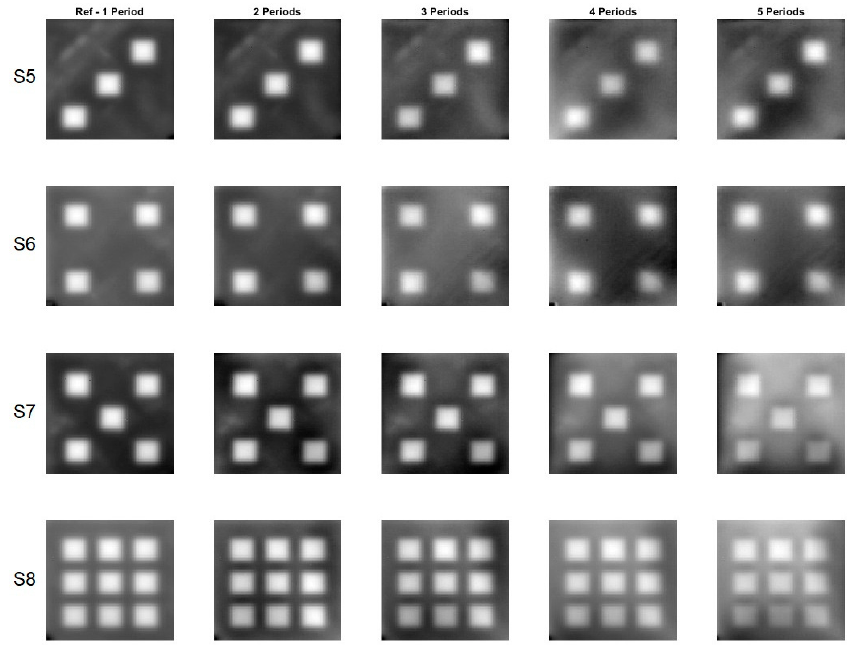
Figure 10. Phase images for the samples with the square cross section defects. A halogen lamp was used as a source of excitation. S5–S8 denotes configuration of the square holes.